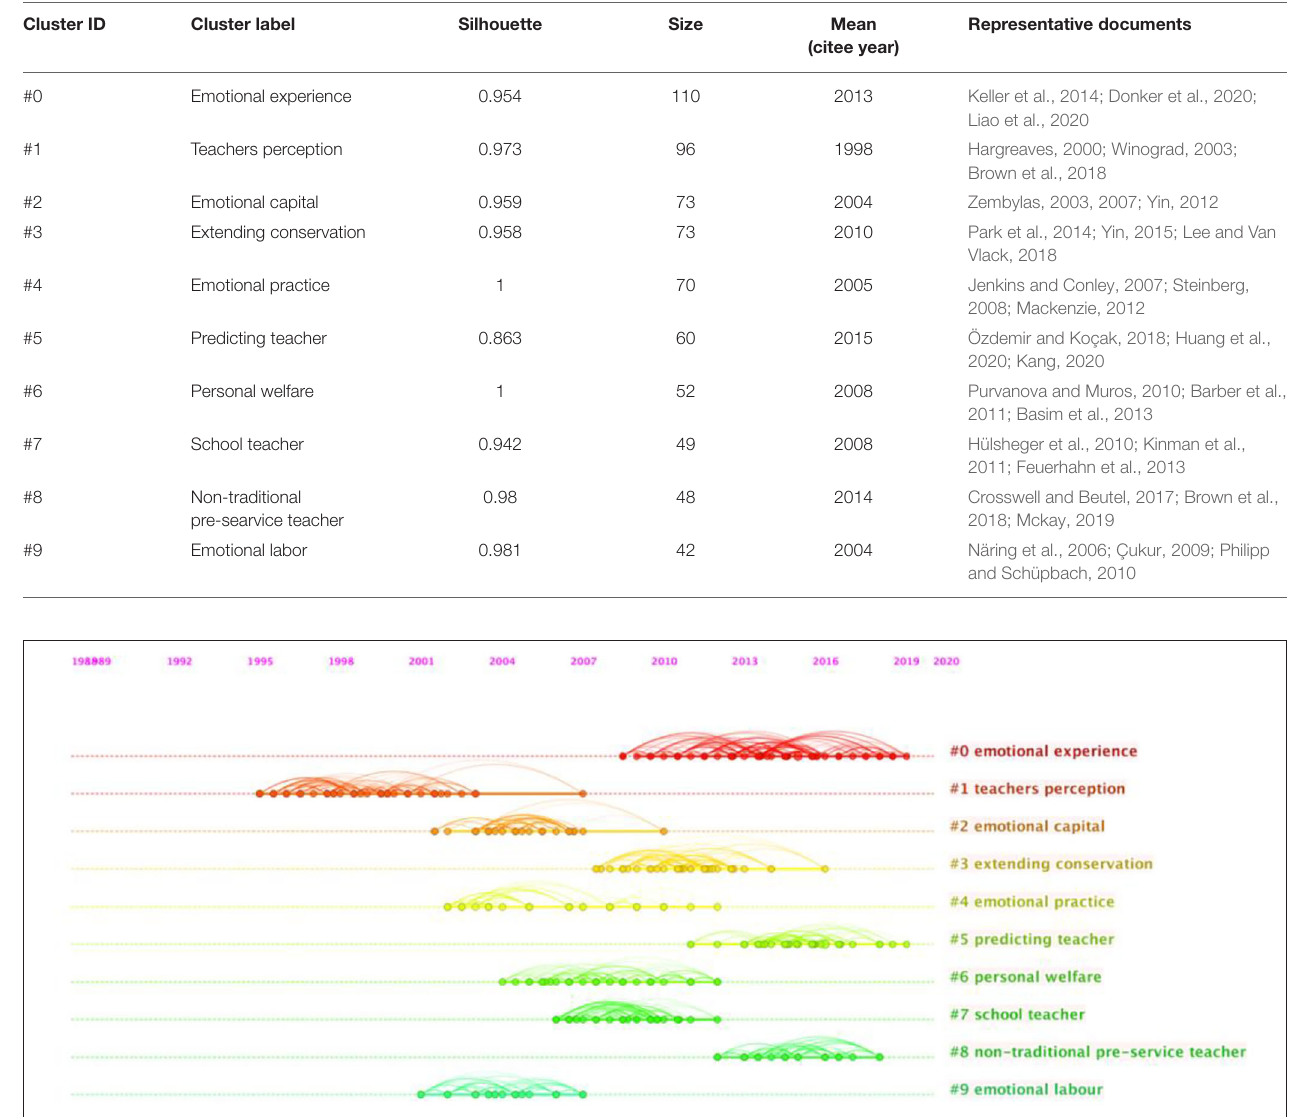
FIGURE 3 | A timeline view of reference co-citation network in TEL documents during